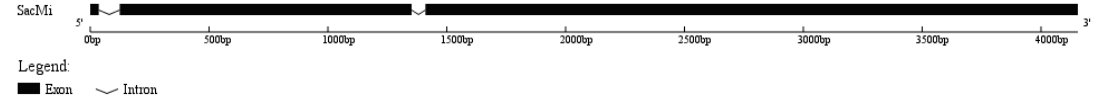
Figure 1. Gene structure of SacMi . Exons are indicated by the black boxes from the predicted translation start site (ATG) and stop codon (TAG) and introns are shown as fold lines.